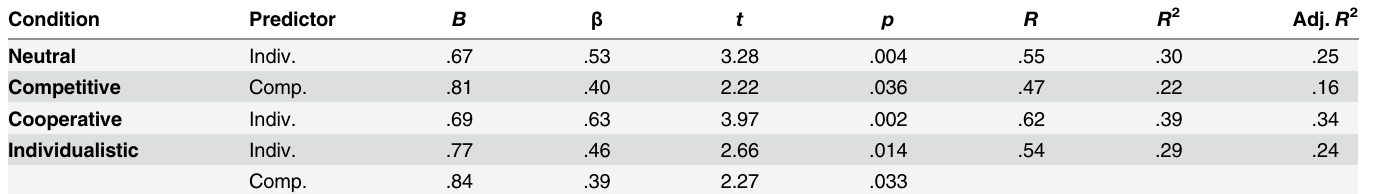
Table 1. Multiple regression of number of defections over 20 rounds on competitive, cooperative, and individualistic SVO questionnaire scores in four treatment conditions. Condition Neutral Competitive Cooperative